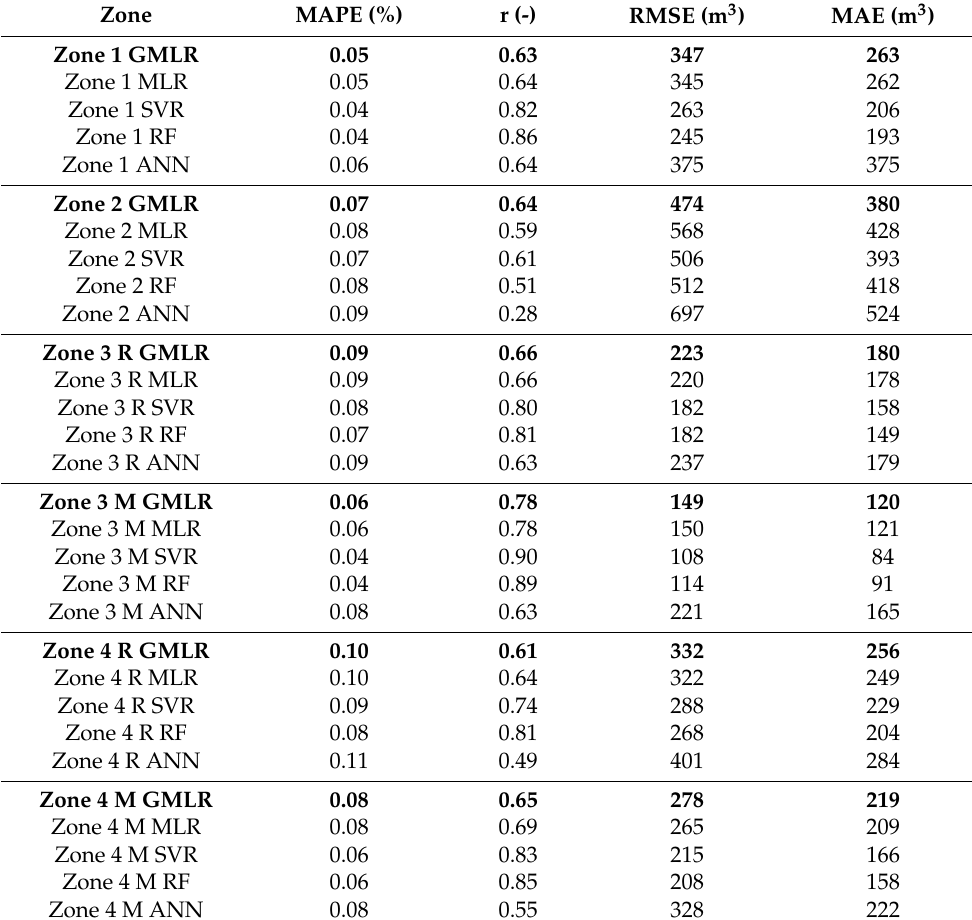
Table 2. Model accuracy for the training data set (2017–2018) for all applied modeling approaches. The results from the GMLR model are highlighted in bold